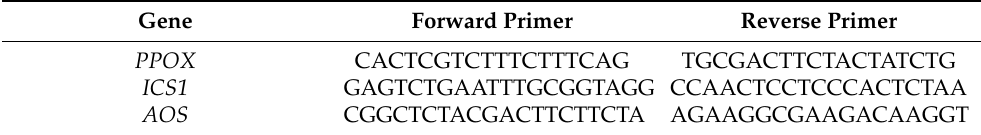
Table 1. Primer sequences used in RT-qPCR